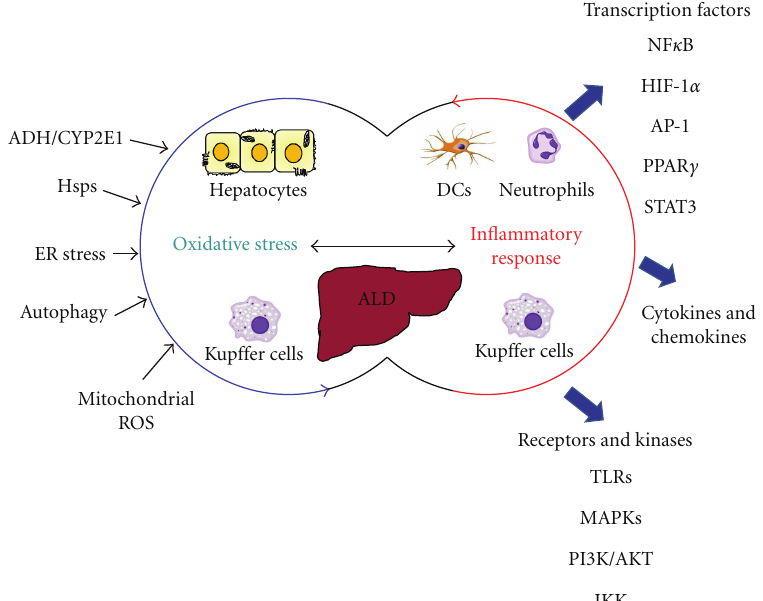
Figure 1: Oxidative stress and inflammation: interacting mechanisms in ALD. The development of alcoholic liver injury is a complex process involving oxidative stress microenvironment in the liver contributed by hepatocytes and macrophages. In addition to the activation of macrophages by gut-derived endotoxin, cellular stress responses contribute to proinflammatory cytokine production creating a tightly interrelated network in